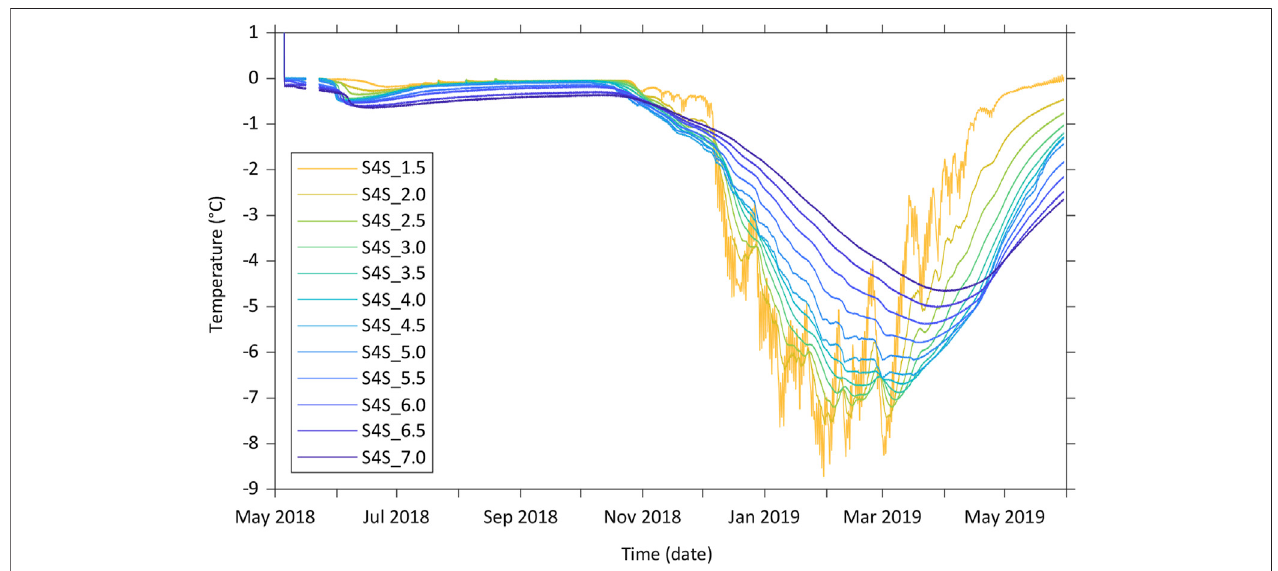
FIGURE 2 | Time series of temperature data measured by the Site 4 shallow-depth thermistor string, colour-coded by thermistor depth. Our thermistor naming convention(e.g.,S4S_1.5)iscomprisedoftheboreholesite(here, “ S4S ” refersto “ Site4shallow ” ),followedbythedepth(inmetres)ofeachthermistorbelowthesurface (here, 1.5